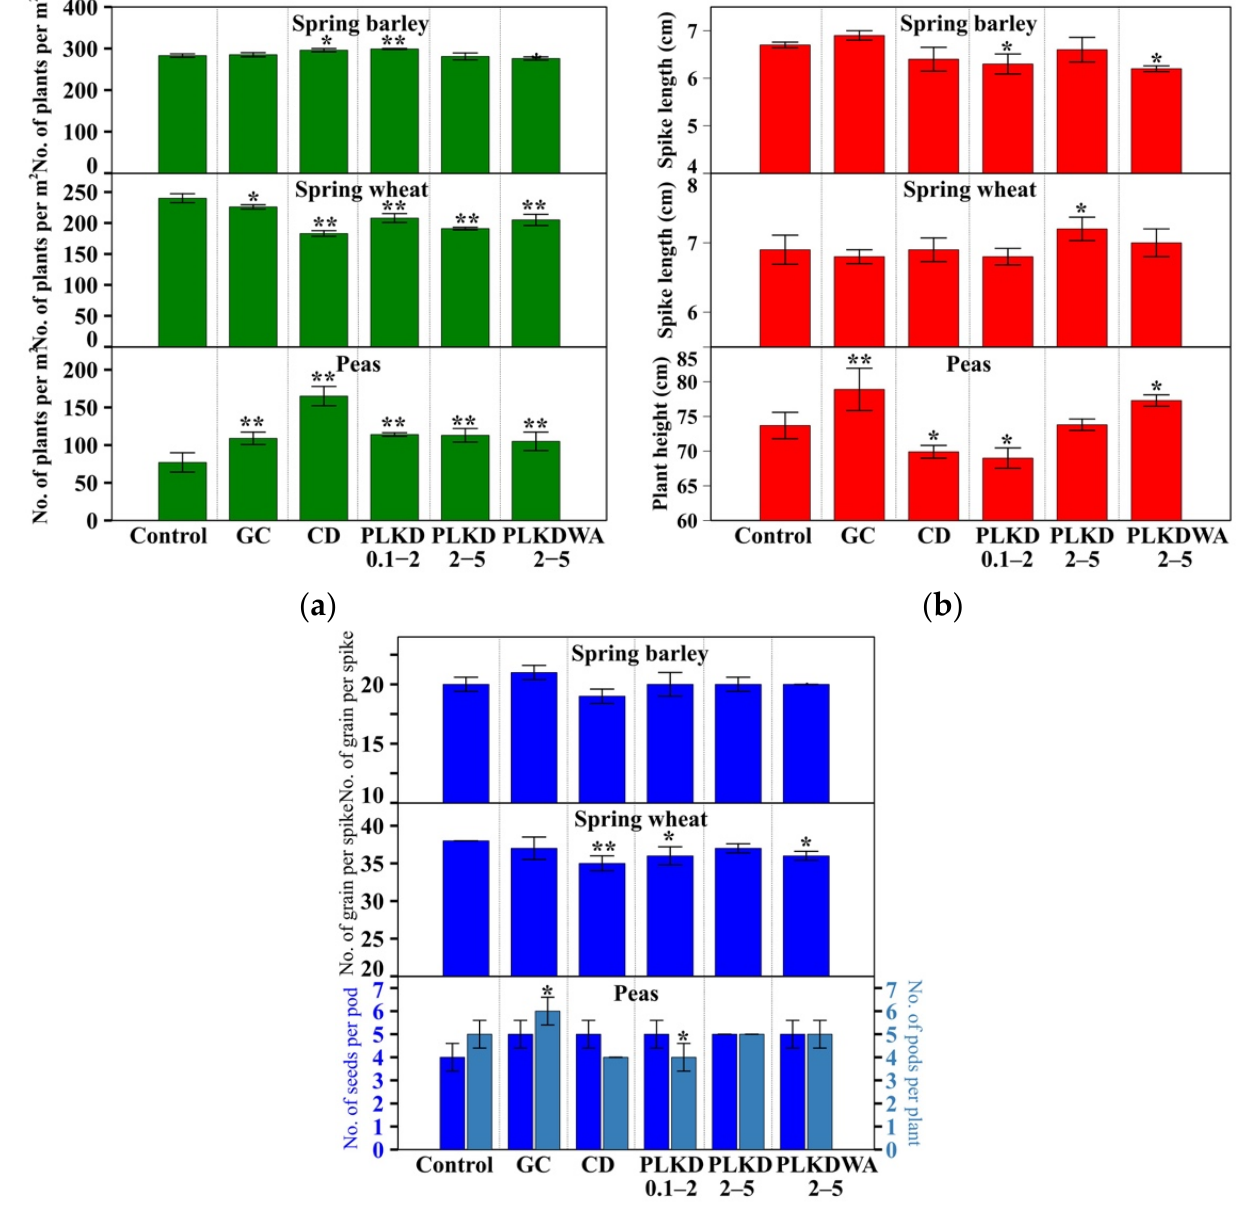
Figure 7. ( a ) The number of plants per square meter of spring barley, spring wheat, and peas; ( b ) the spike length of spring barley, spring wheat, and plant length of peas; ( c ) the number of grains per spike of spring barley, spring wheat, and the number of seeds per pod and number of pods per plant of peas. * and ** indicate significant differences according to Fisher’s least significant difference test. Statistically significant at * p < 0.05 and ** p < 0.01 level.